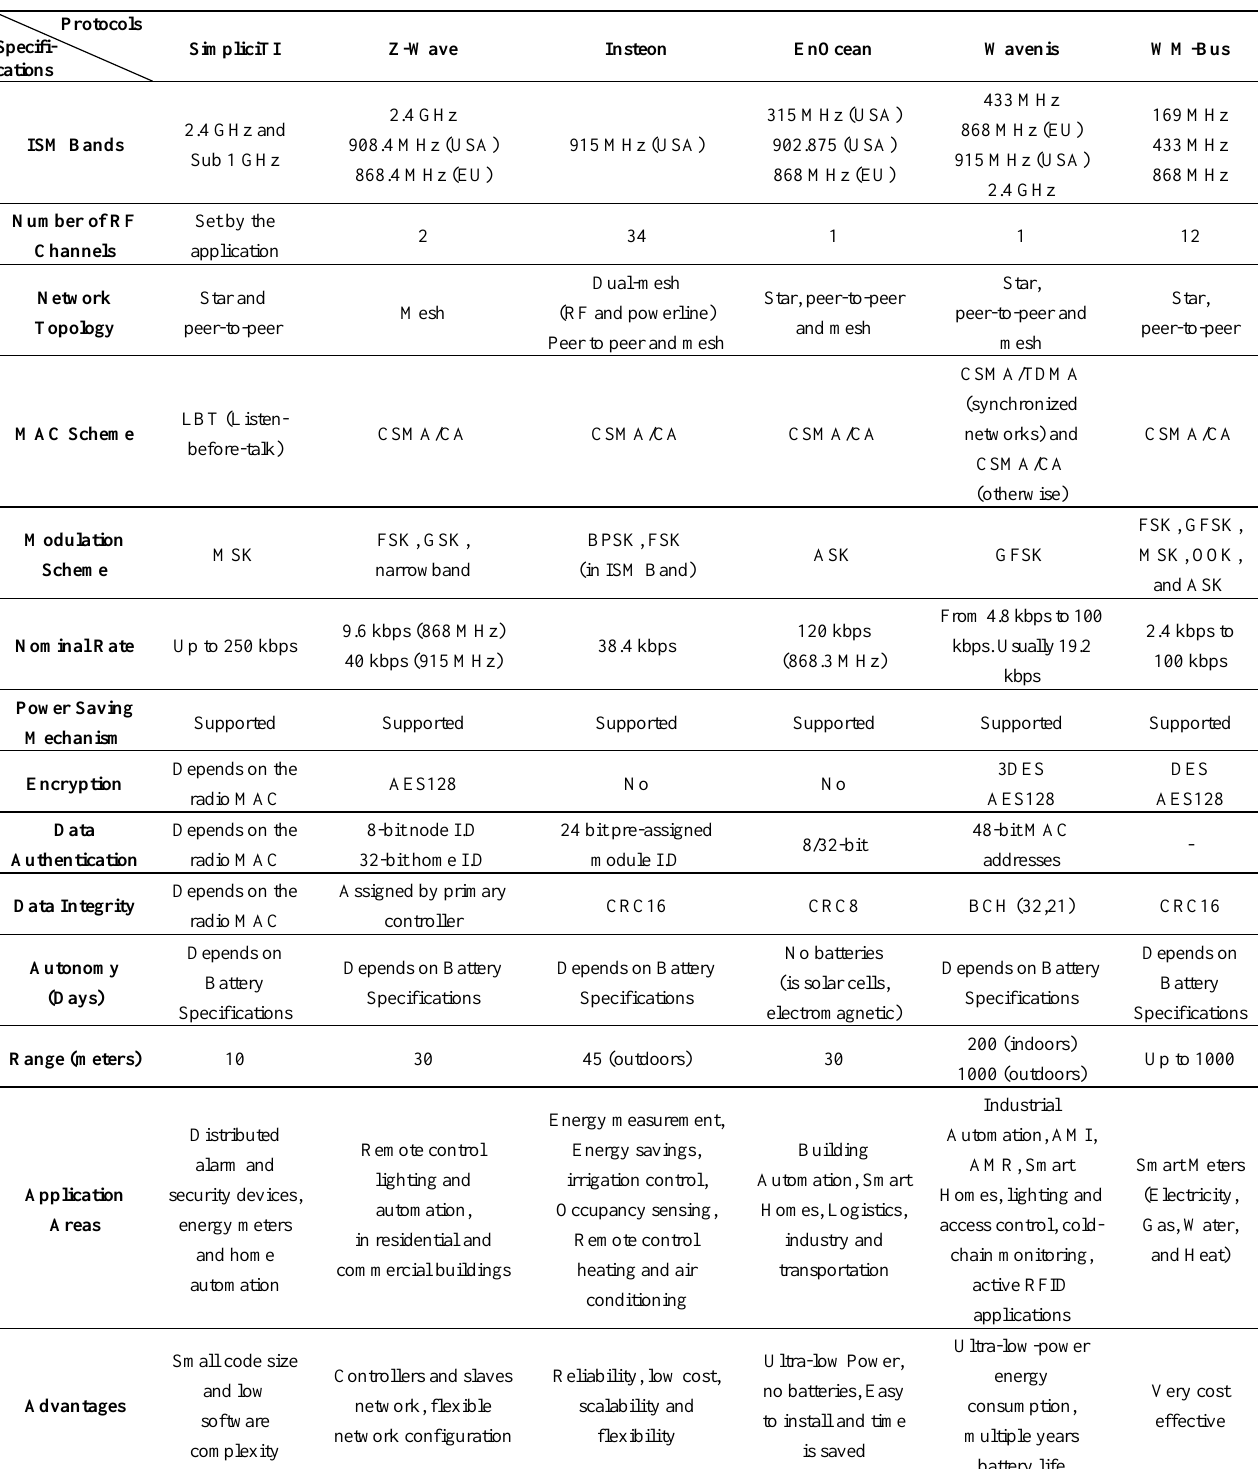
Table 2. Wireless Network Standards Not Based on IEEE